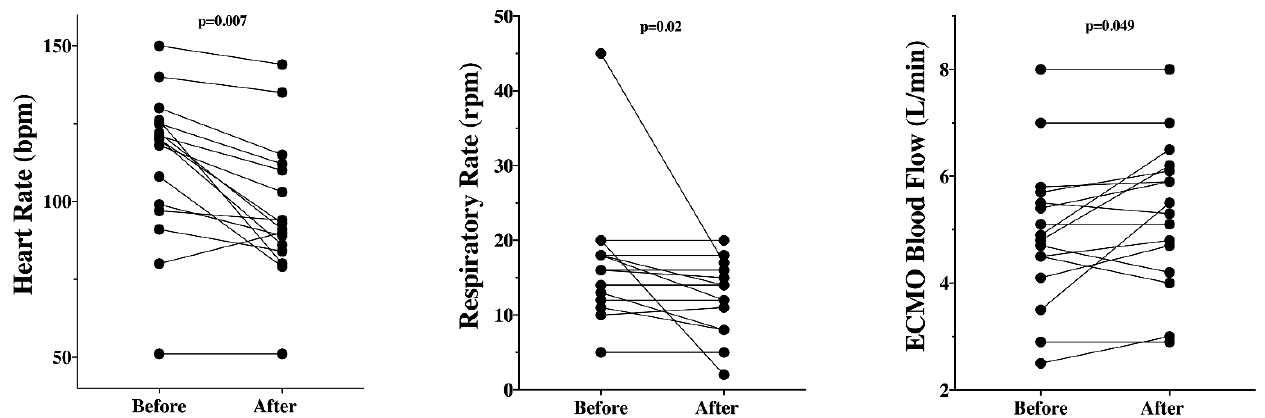
Figure 2. Significant changes in different variables before and after the implementation of V-AV ECMO in those patients ( n = 16) with initial VV-ECMO configuration.